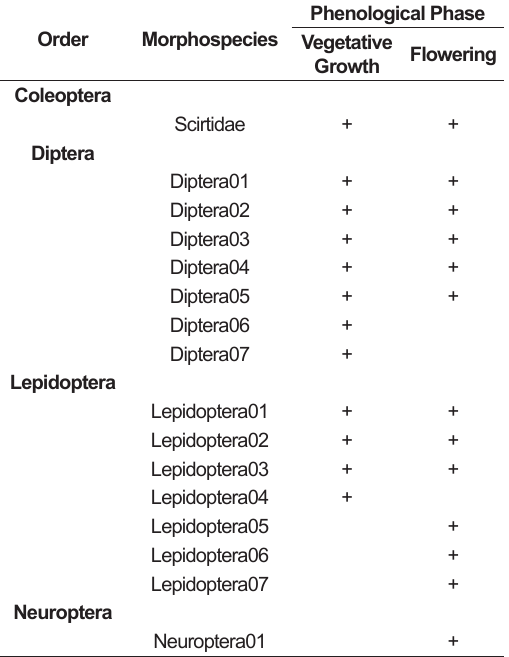
Table 1. Morphospecies occurrence of aquatic insect larvae found in A. distichantha of the rocky walls at the left bank of the Paraná River (PR, Brazil) during both phenological